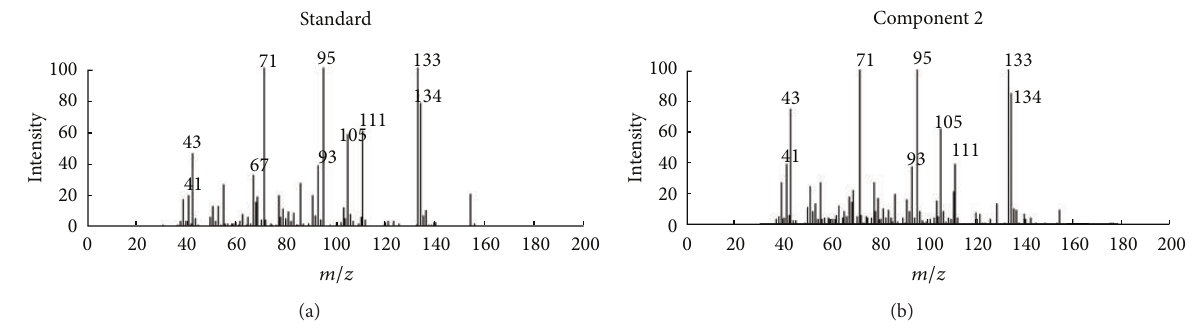
Figure 4: Resolved mass spectrum of component 2 by SFA and standard mass spectrum of 2,4-dimethylbenzaldehyde.